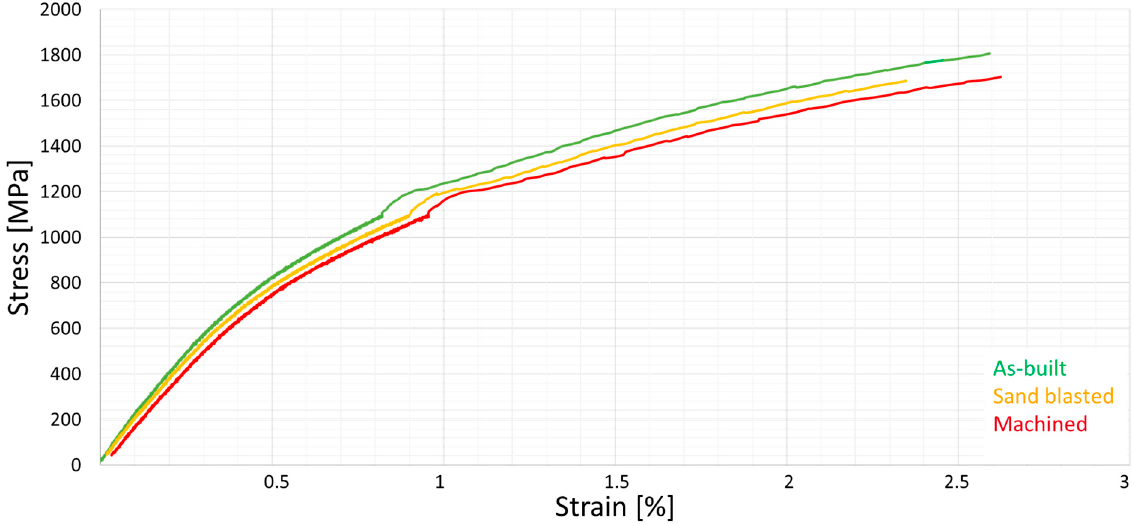
Figure 9. Stress–strain curves for 1.2343/H11 tool steel tensile samples (B4x20). The surfaces were differentiated between as-built, sand blasted, and machined.